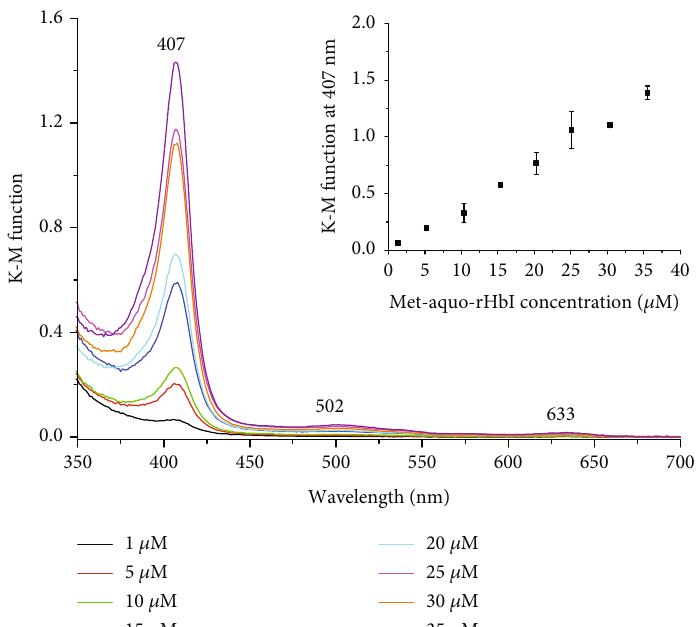
Figure 5: Spectra of di ff use re fl ectance transformation for di ff erent concentrations (1 to 35 μ M) of immobilized met-aquo rHbI on collagen sponge. The inset shows variation in absorbance at 407nm in each concentration showing a linear fi t.